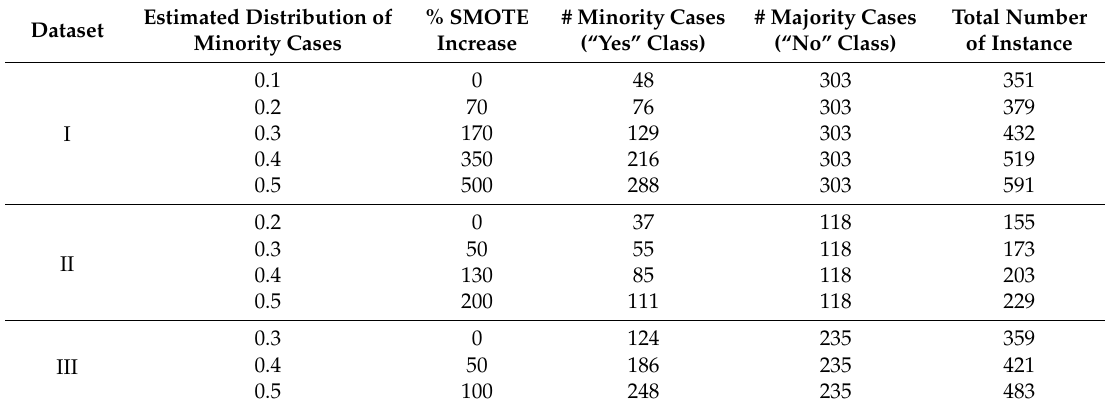
Table 11. Distribution of minority